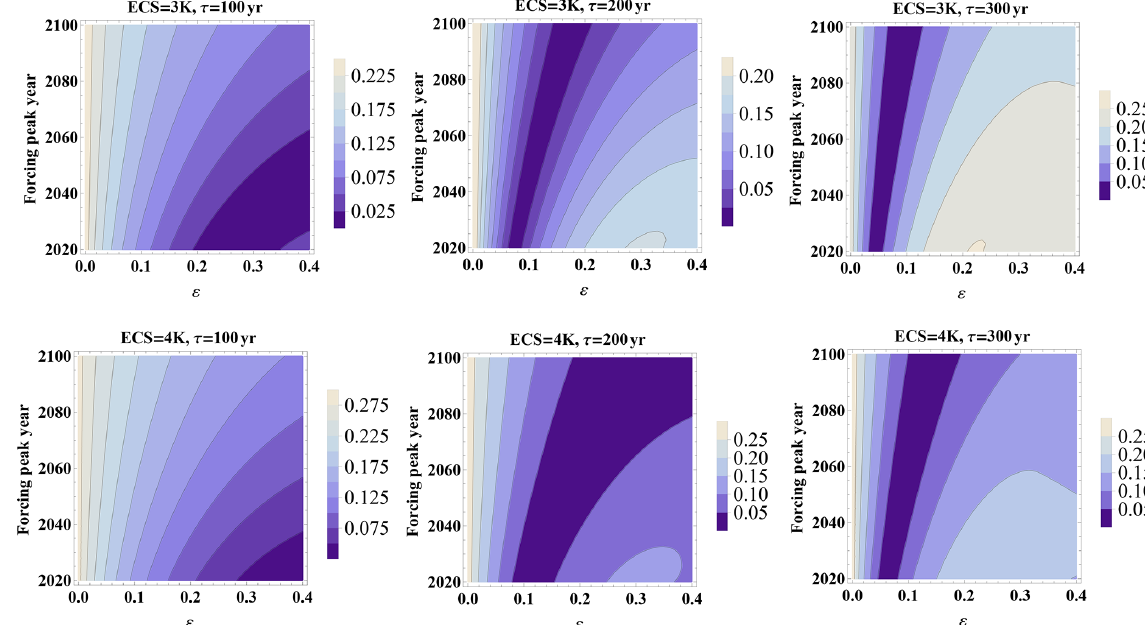
Figure 11. Comparing GMT (K) maxima of the two-box model and the one-box model, the latter being adjusted to the former by prescribing the linearly transformed ECS and TCR according to the scheme ETE. Abscissa is ε and ordinate is changed peaking year t 1 , transformed to years however, for the two-box ECS of 3 and 4K, and τ = 100, 200, 300 years. The relative error (max. GMT difference normalized by the max. GMT of the two-box model) is markedly smaller than for the case of prior adjustment.